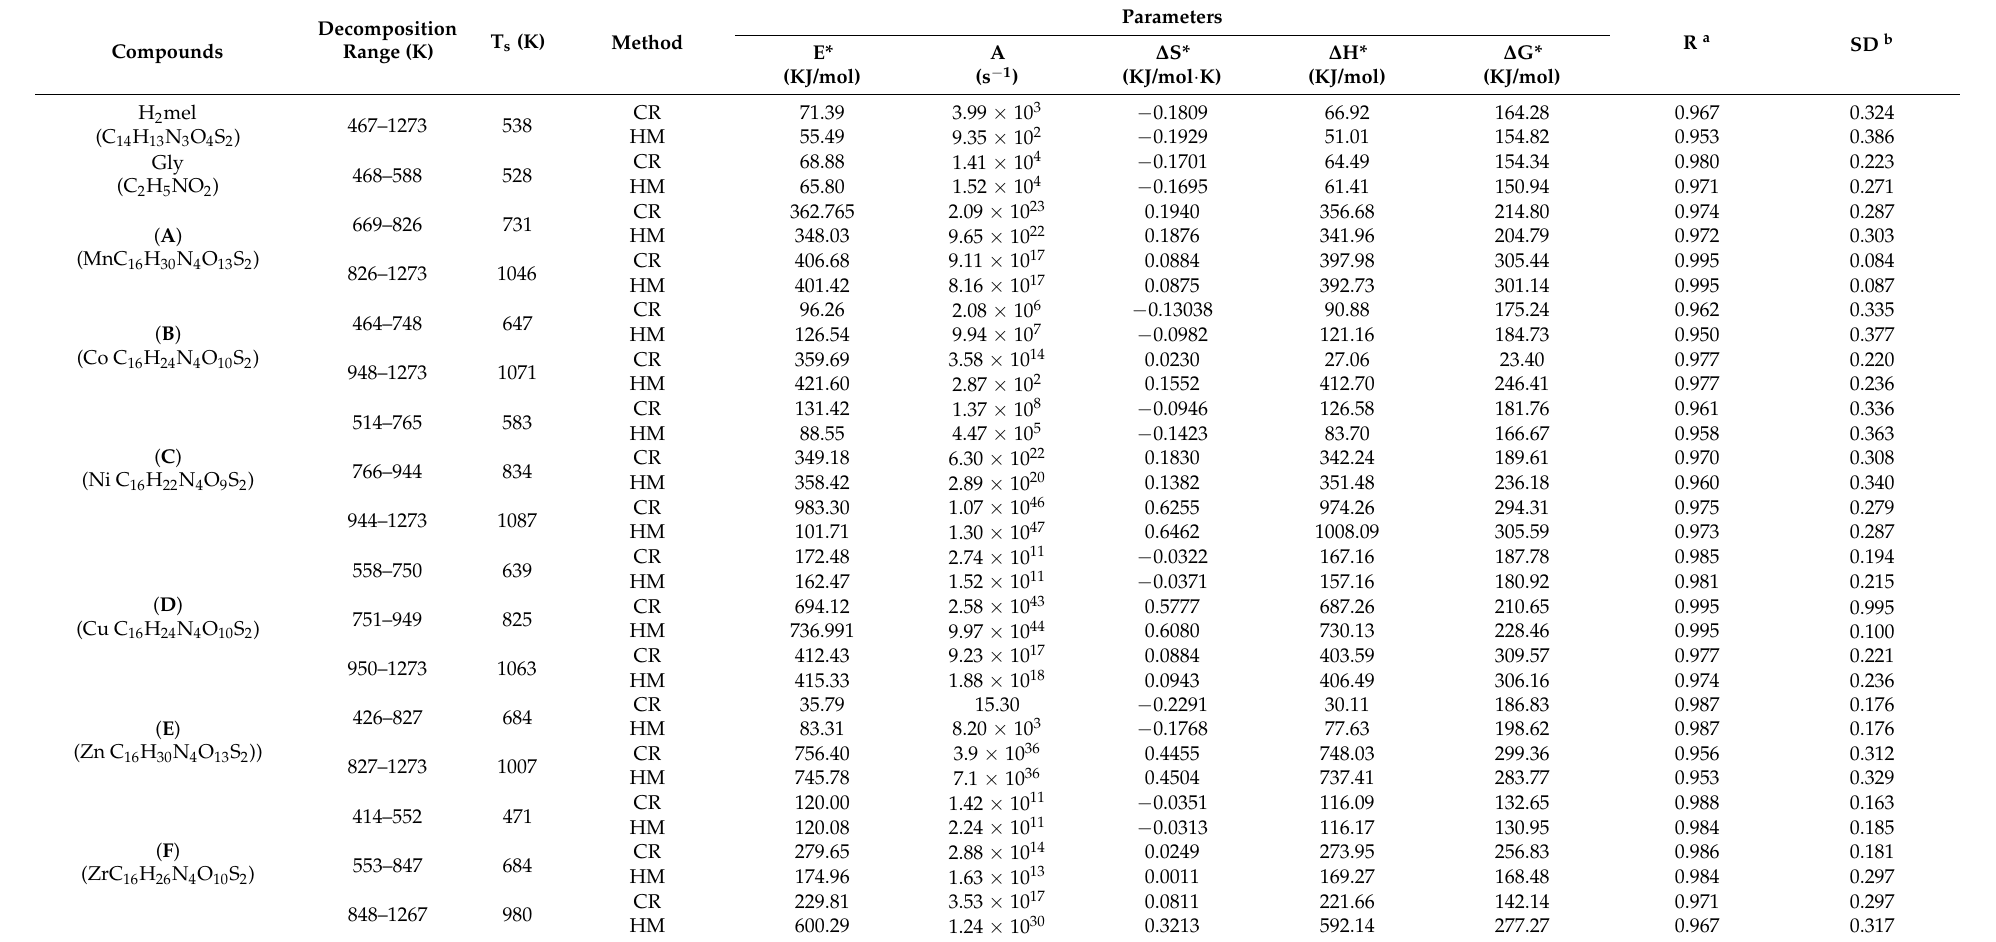
Table 3. Thermal behavior and kinetic parameters determined using Coats–Redfern (CR) and Horowitz–Metzger (HM) operated for H 2 mel, Gly and their metal complexes.